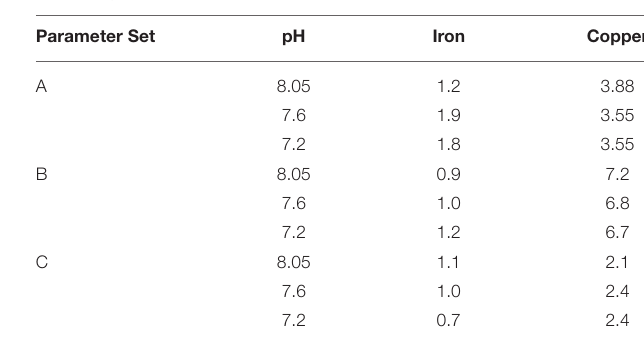
TABLE 4 | RMSE (nmol L − 1 ) obtained on comparison of measured MeAL x concentrations with calculated MeAL x concentrations obtained using